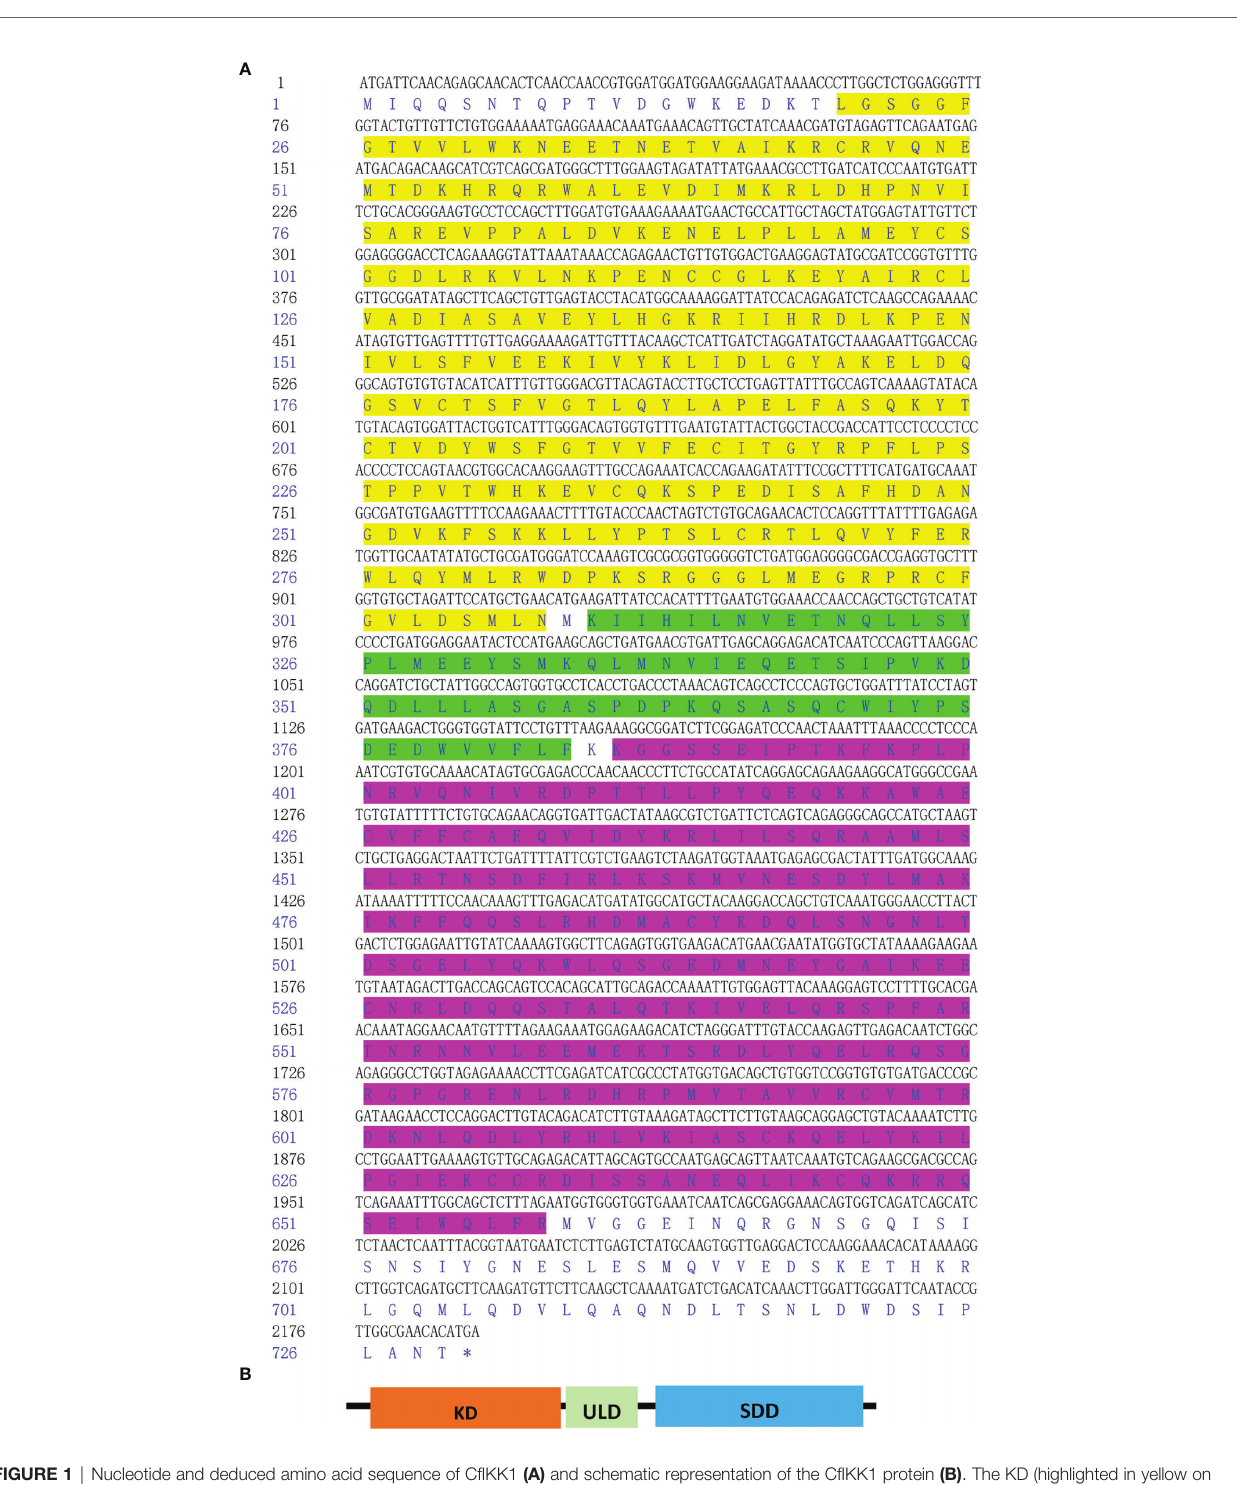
FIGURE 1 | Nucleotide and deduced amino acid sequence of CfIKK1 (A) and schematic representation of the CfIKK1 protein (B) . The KD (highlighted in yellow on the sequence), ULD (green highlighted), and SDD (fuchsia highlighted) were predicted using the NCBI Conserved Domain search program (https://www.ncbi.nlm.nih. gov/Structure/cdd/wrpsb.cgi). KD, kinase domain; ULD, ubiquitin-like domain; SDD, scaffold dimerization